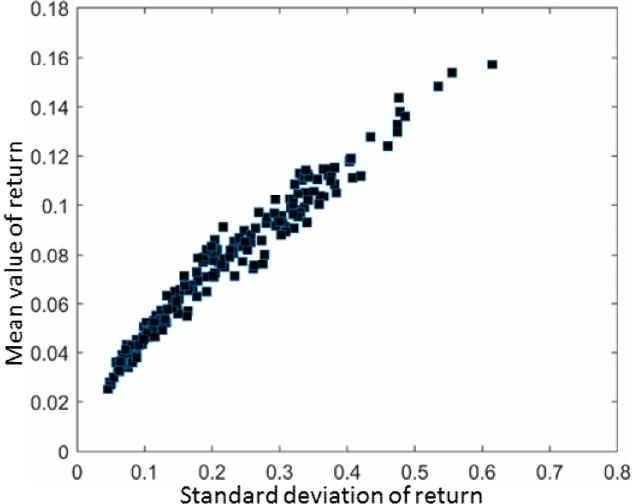
Figure 3. Risk − return diagram. Figure 3. Risk−return diagram.